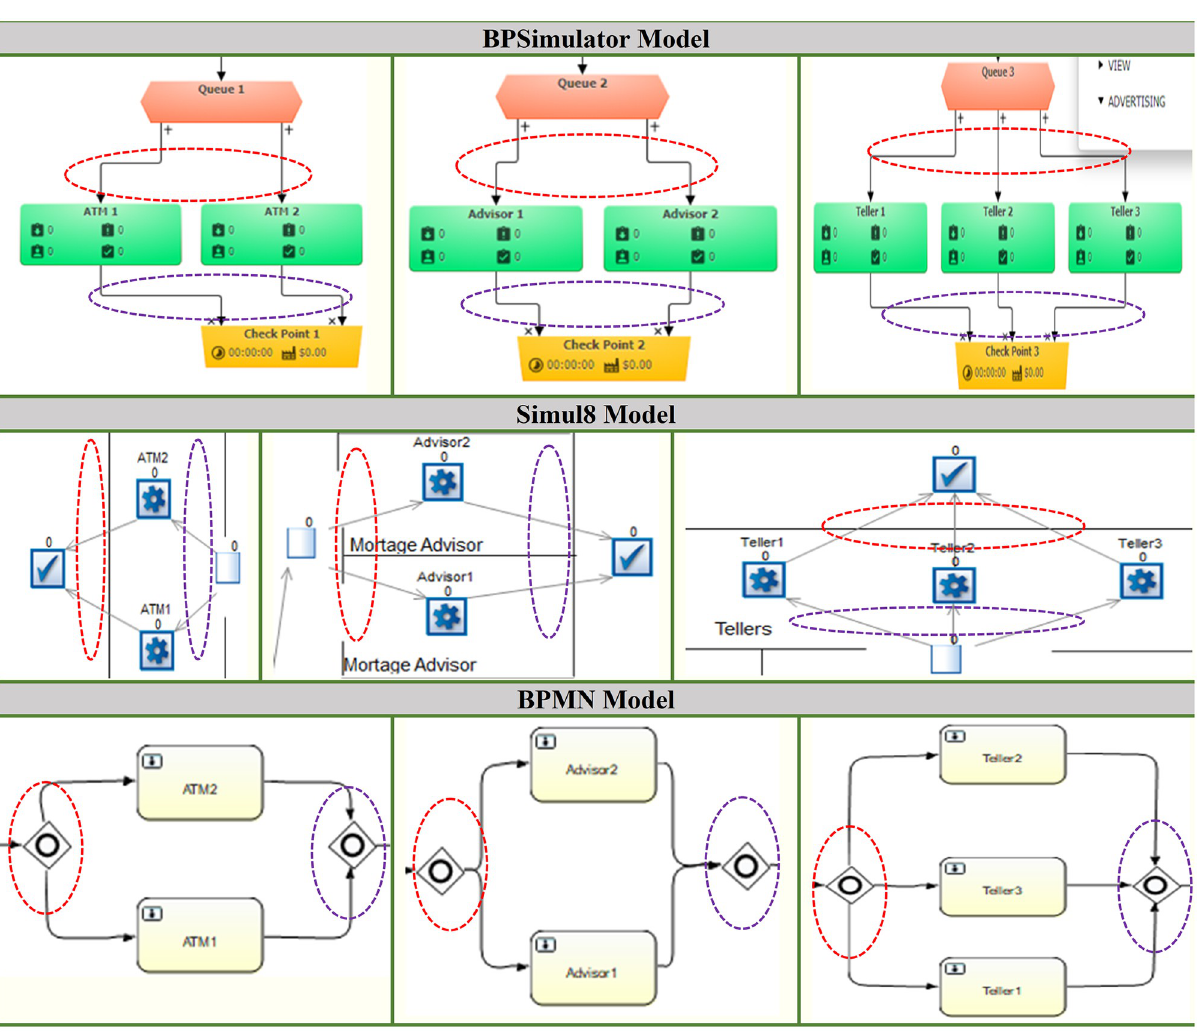
Fig 13. Three parts of bank model ATM, advisor and teller are shown. The connectors in Red oval in BPSimulator and Simul8 model is converted to opening parallel gateway. The connectors in purple oval is closing